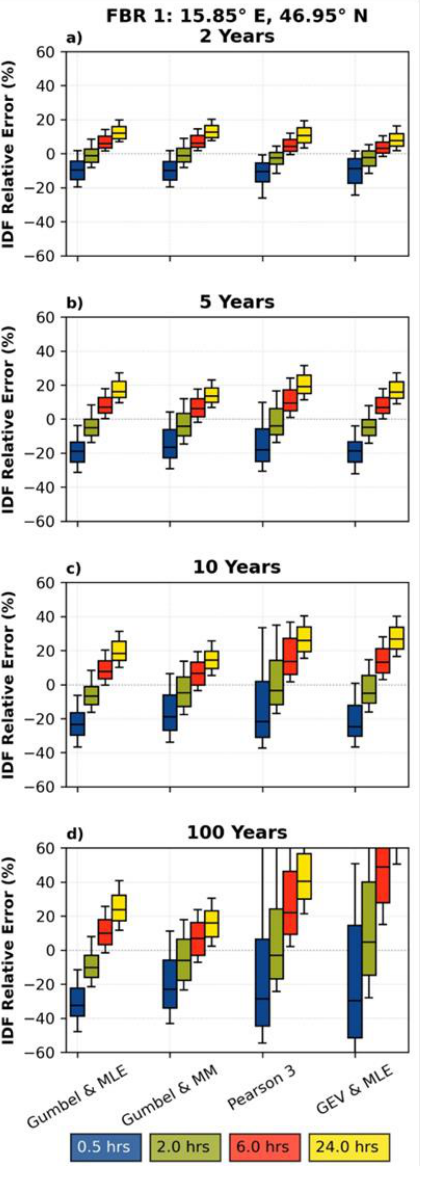
Figure A12. Percent relative error of precipitation AMS from IMERG compared to the gauge-based cells over FBR 1 ( left ) and WGEW 2 ( right ) for durations of 0.5, 2, 6 and 24 h. From top to bottom: for the 2, 5, 10, and 100 year return periods. The lower whiskers are located at the 10th percentile and the upper whiskers at the 90th percentile.